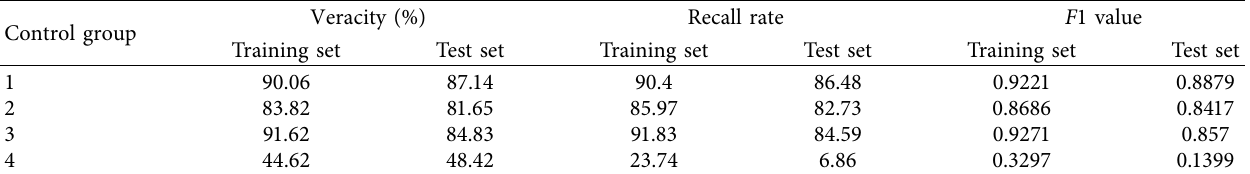
Table 2: Model performance of the control group.